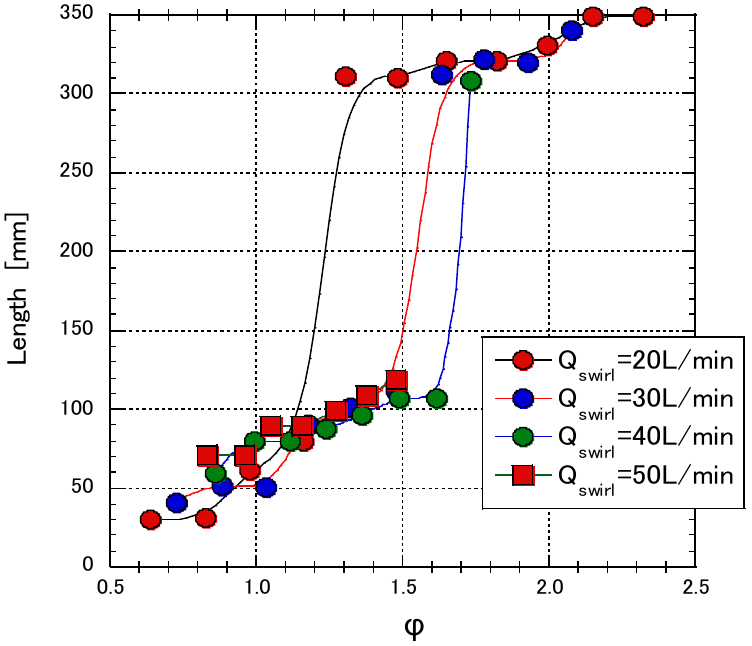
Figure 14. Relationship between equivalent ratio and flame length when the fuel flow rate Qfuel is changed.